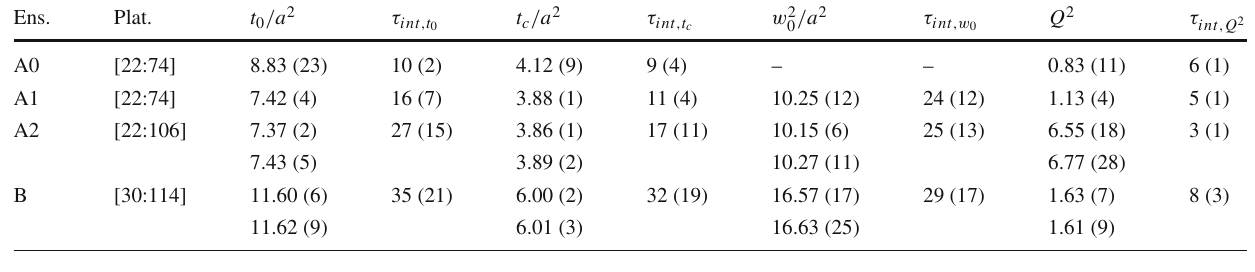
Table 3 Flow measurement results and topological charge with inte- grated autocorrelation times. The second column specifies the plateau range of x 0 values where E ( x 0 , t ) and Q ( x 0 , t 0 ) are averaged. The sec- Ens.